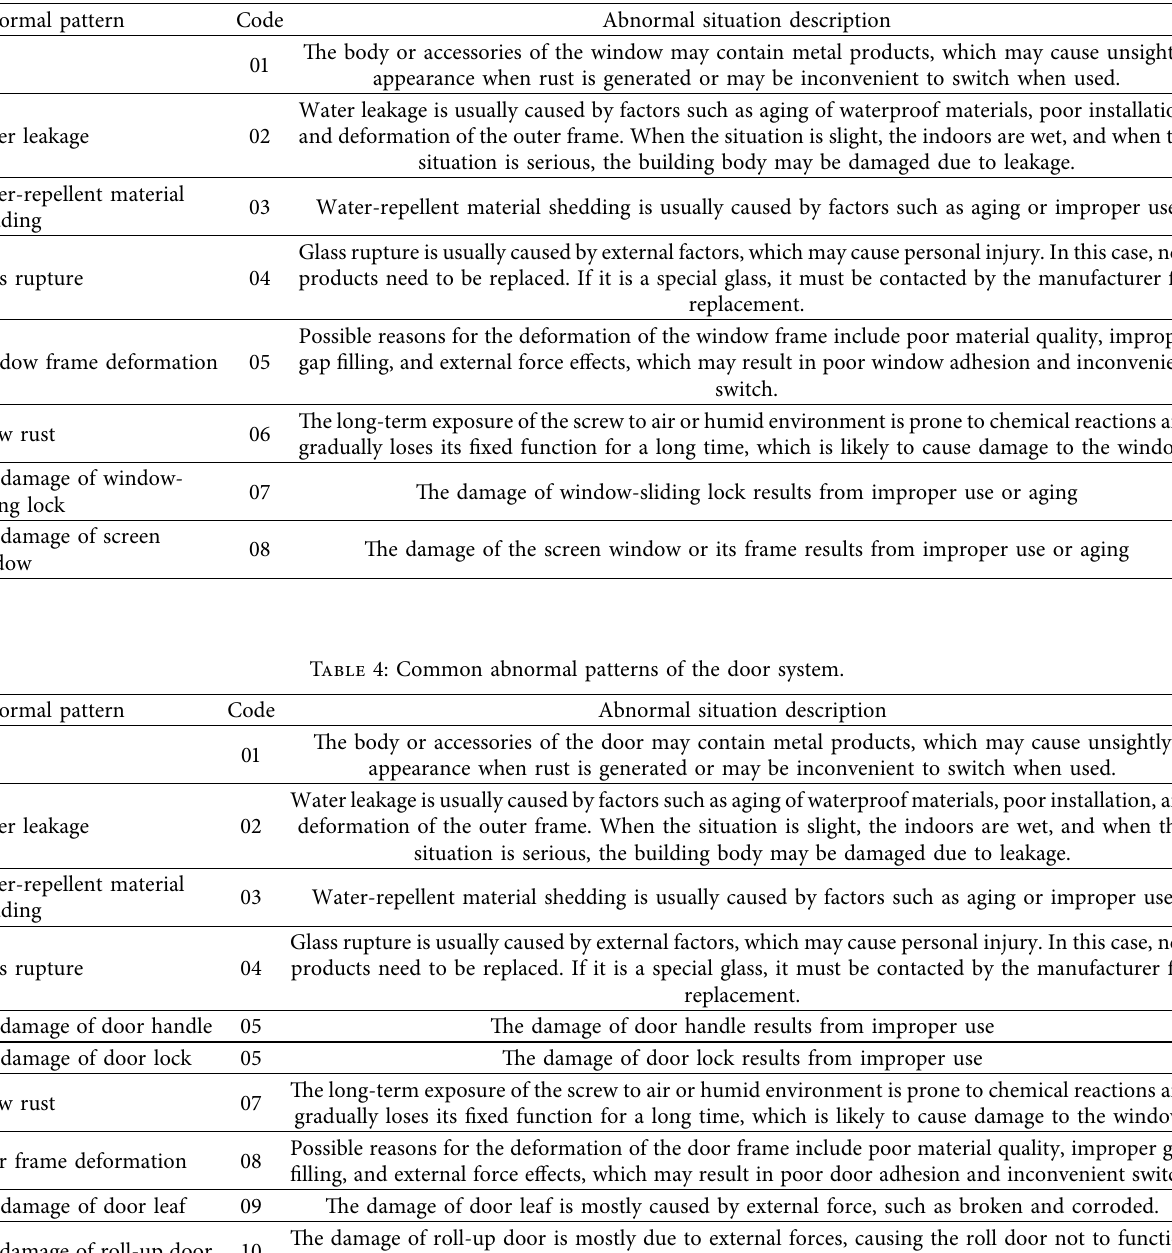
Table 3: Common abnormal patterns of the window system.